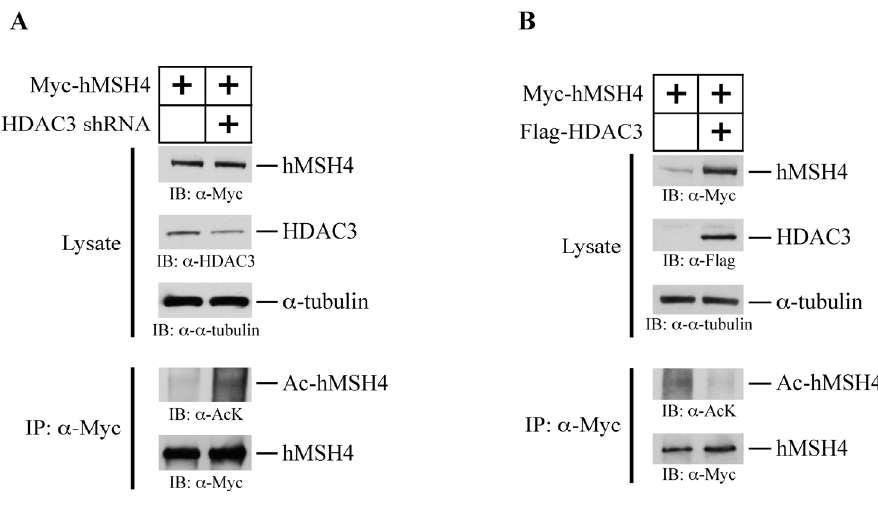
α -Acetylated-Lysine antibody; ( B ) Effects of HDAC expression on hMSH4